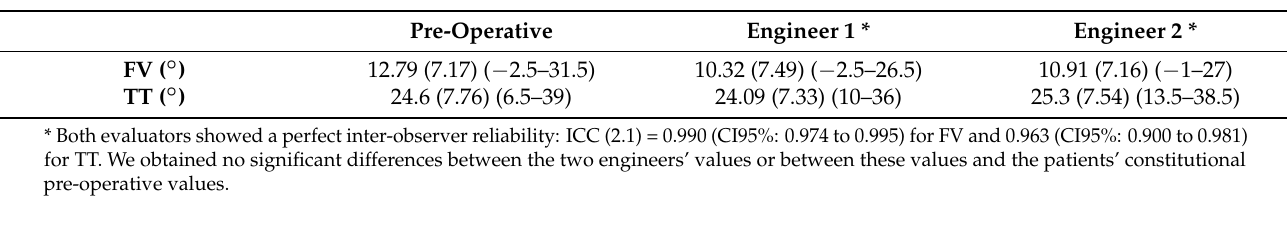
Table 4. Axial measurements on the virtual TKA 3D CT-scan-based virtual models. Results are shown as mean value (standard deviation) and (range). FV: femoral version, TT: tibial torsion. Negative values for FV indicate femoral retroversion, while positive values indicate femoral anteversion. n = 28 (we lacked pre-operative information in seven cases since FV and TT are not standardized angular values in surgical planning).